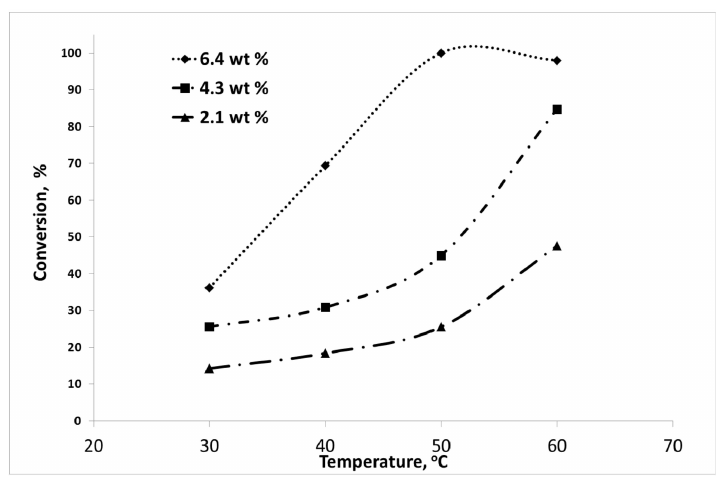
Figure 4. The effect of temperature on waste vegetable oil (WVO) conversion at the MeOH/WVO molar ratio of 11.5:1 in the presence of 2.1, 4.3 and 6.4 wt % of TZT catalyst, at temperatures of 30, 40, 50 and 60 ◦ C.